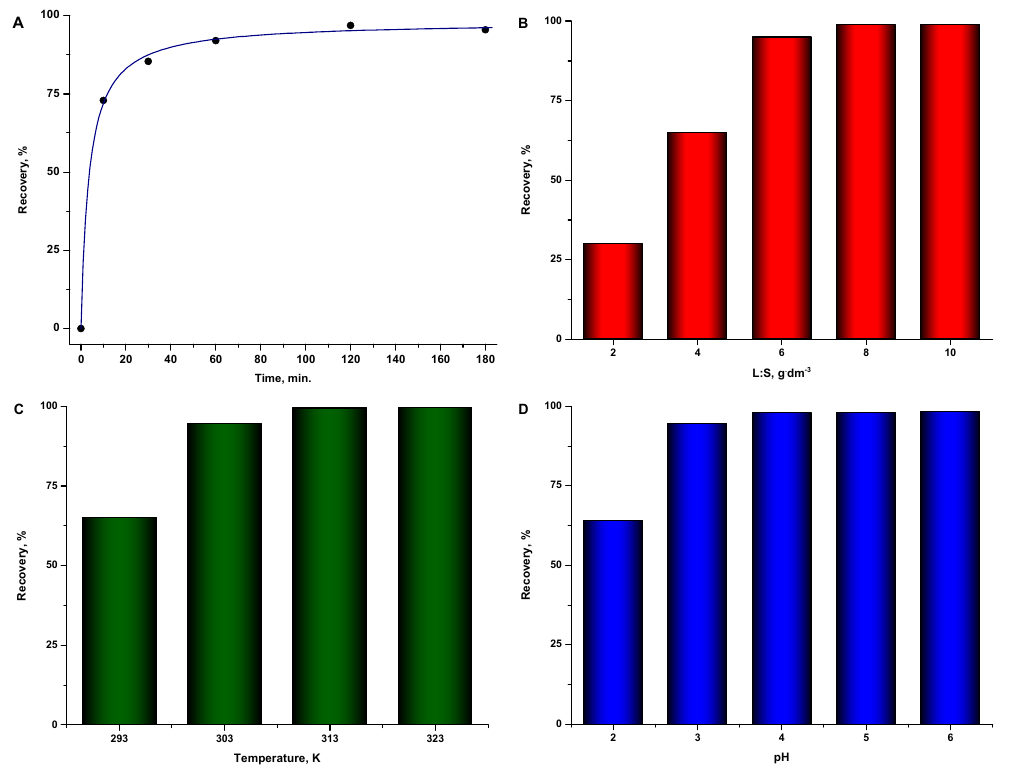
Figure 7. Determination of optimal sorption parameters for copper(II) ions on R-SiO 2 -2h. ( A ) equilib- rium time; ( B ) influence of sorbent content; ( C ) influence of temperature; ( D ) influence of pH.